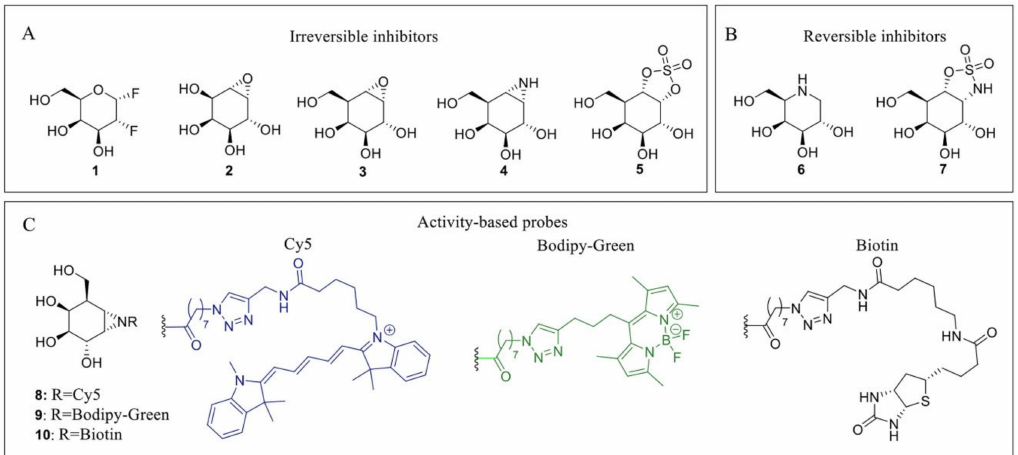
Figure 2. α -GalA inhibitors and activity-based probes (ABPs). ( A ) Irreversible inhibitors: 2-deoxy-2-fluoro-D-galactosyl fluoride 1 , conduritol C 2 , cyclophellitol epoxide 3 , cyclophellitol aziridine 4 and cyclosulfate 5 . ( B ) Reversible inhibitors: Gal-DNJ 6 ; cyclosulfamidate 7 . ( C ) ABPs: Cy5 probe 8 (blue), Bodipy-green probe 9 (green) and biotinylated probe 10